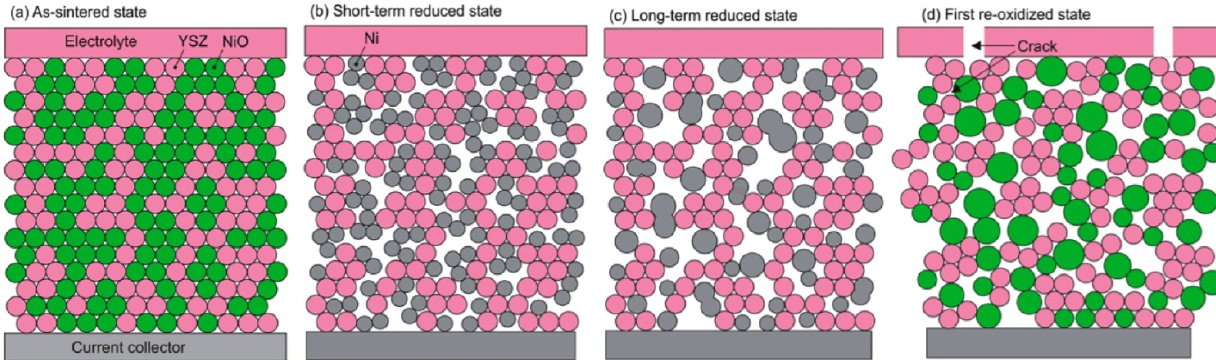
Figure 1. Microstructural changes during a RedOx process in Ni-YSZ (yttria stabilized zirconia) based anodes